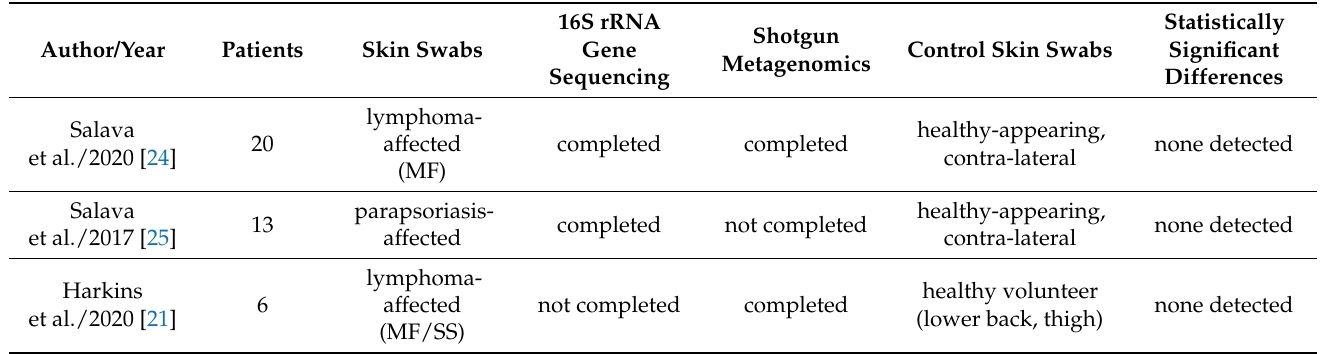
Table 1. Methods and controls used in recent skin microbiome